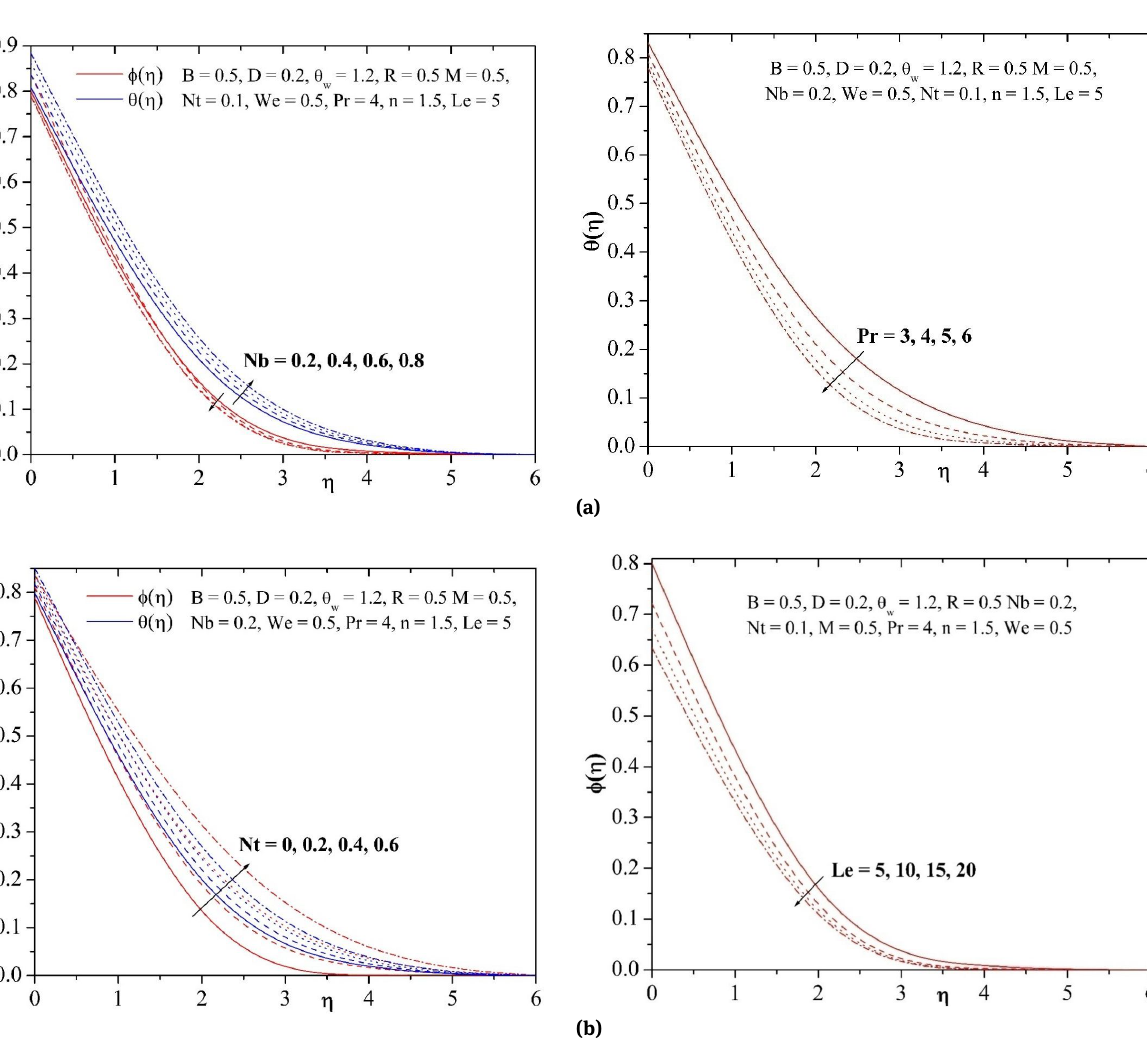
Fig. 7: (a) Influence of Pr on temperature profile. (b) Influence of Le on concentration